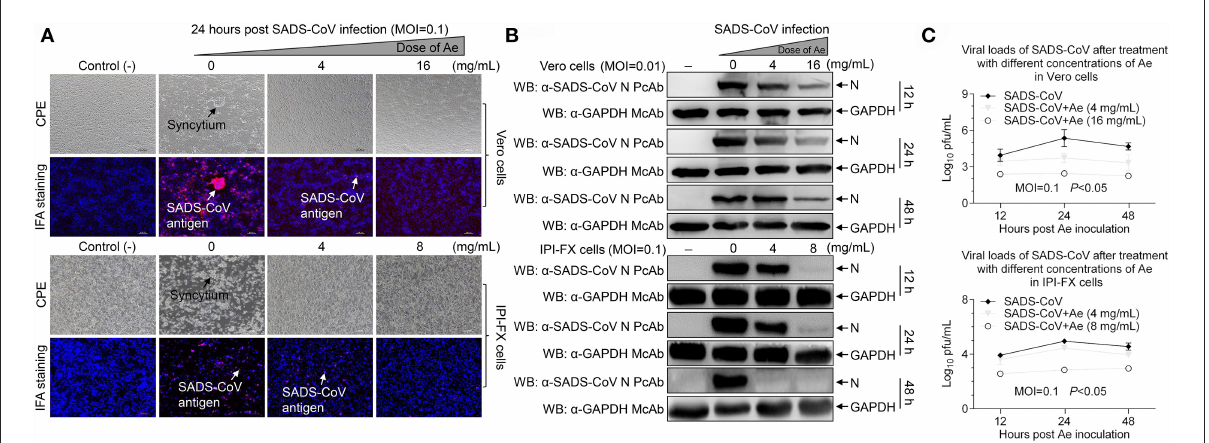
FIGURE1 The effect of Ae on SADS-CoV infectivity. (A) Vero and IPI-FX cells were pre-incubated with different concentrations of Ae (2–16 mg/ml) for 1h, followed by infection with SADS-CoV at an MOI of 0.1. After 1.5h, the cells were re-treated with Ae or the normal medium. The positive red IFA signals for SADS-CoV N protein were monitored by fluorescence microscopy at 24 hpi. CPE and SADS-CoV antigens were indicated by arrows. Vero and IPI-FX cells were treated as above described, cell lysates were prepared at indicated time points (12h, 24h, and 48h), and the expression level of N and GAPDH proteins was examined by Western blot using anti-SADS-CoV N polyclonal antibody and anti-GAPDH monoclonal antibody (B) , or viral titers were determined by the TCID 50 assay (C) . Results are representative of three independent experiments (mean ± SD). n =